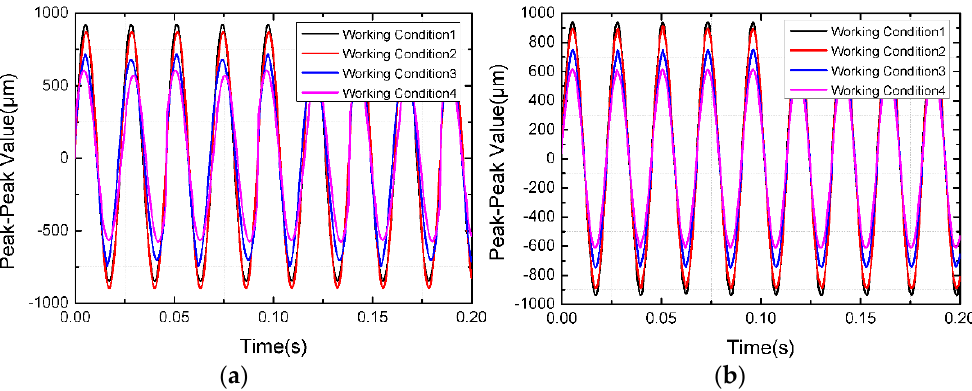
Figure 14. Vibration control of ISFBD in time domain spectrum: ( a ) theoretical results; ( b ) experimental results. Table 3. Vibration control under different working conditions in time domain spectrum.